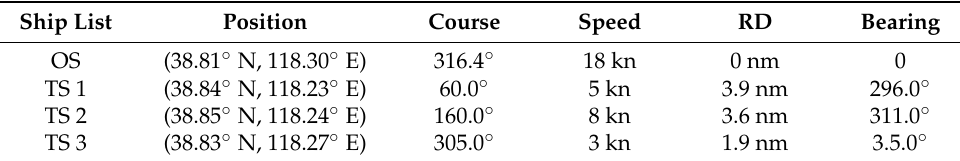
Table 7. Initial information (multi-ship encounter in a busy sea area).